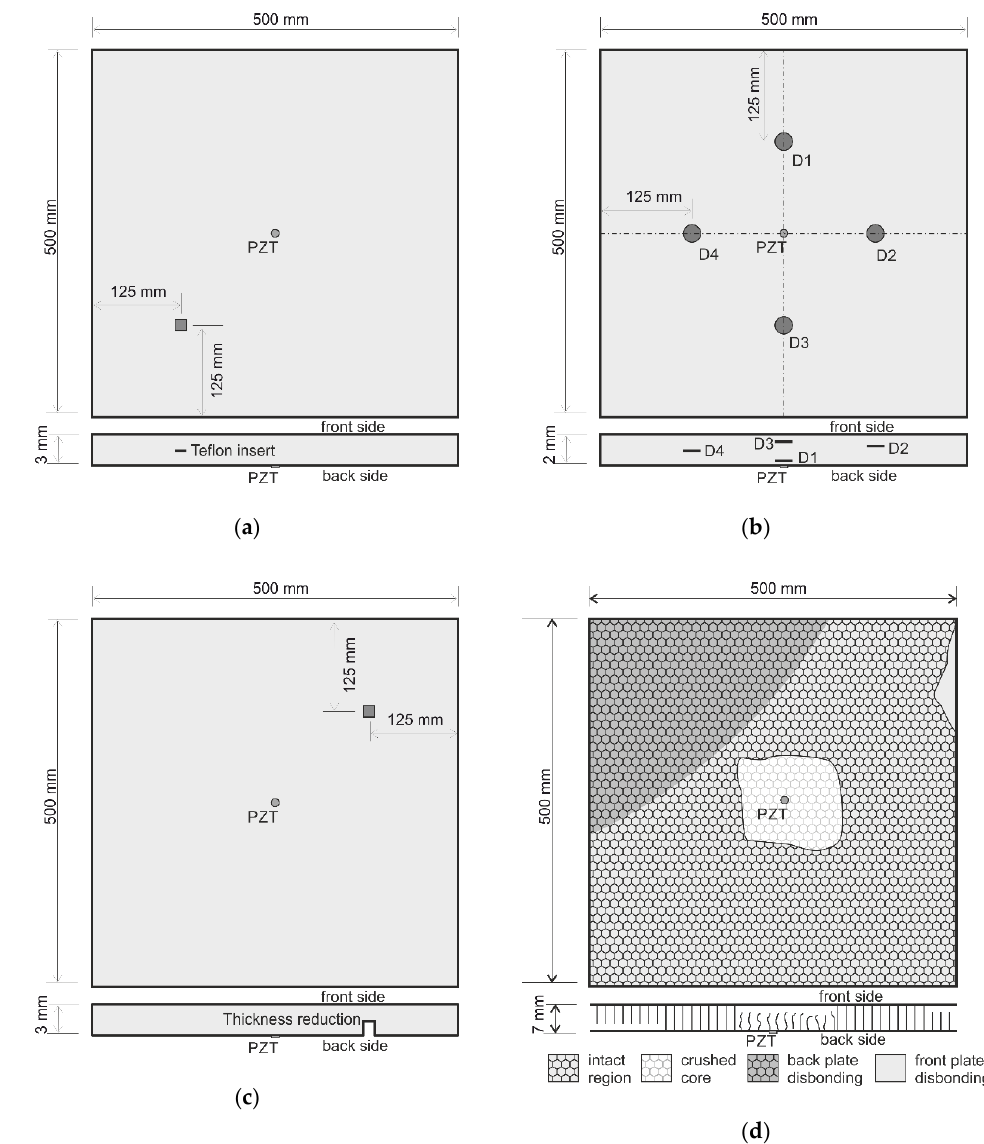
Figure 5. Specimens with defects schemes: ( a ) Carbon fiber reinforced polymer (CFRP); ( b ) glass fiber reinforced polymer (GFRP); ( c ) randomly oriented short fiber reinforced polymer (SFRP) and ( d ); honeycomb sandwich panel